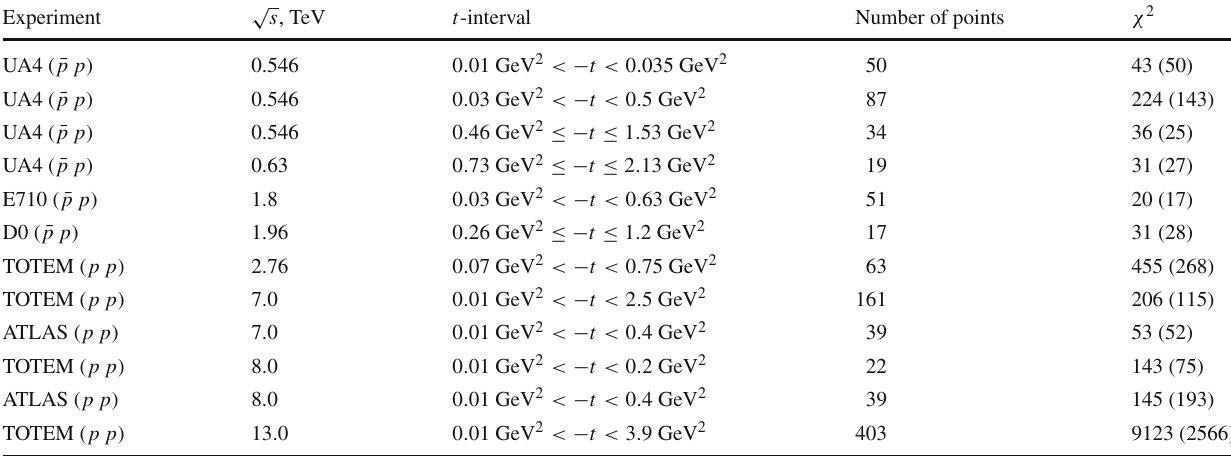
Table 3 The quality of the model predictions for the nucleon–nucleon EDS angular distributions at ultrahigh energies. The numbers in parentheses are related to the three-Reggeon eikonal approximation wherein the HP exchange contribution is taken into account Experiment